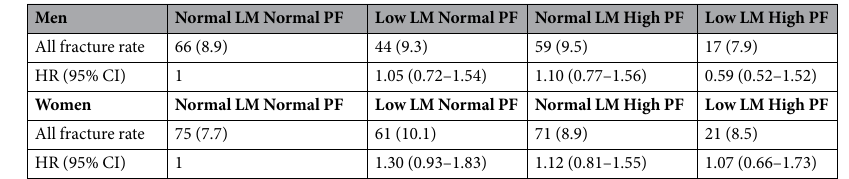
Table 6. Cox proportional hazard models for all incidental fractures according to body composition. Data are shown as HRs (95%